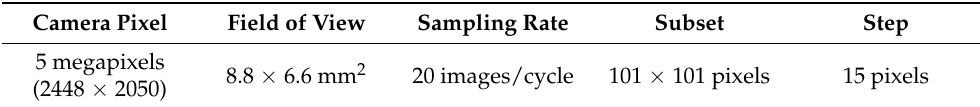
Figure 4. ( a ) Schematic diagram of the observation field for the DIC measurement and ( b ) observa- tion field captured by the camera during the test. Table 3. DIC measurement parameters used in this work.